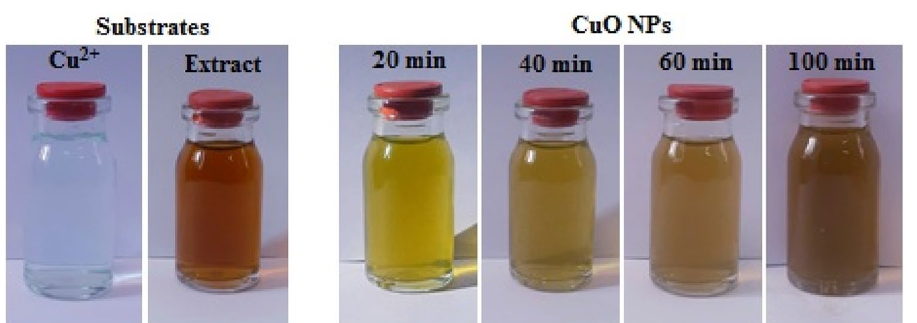
Figure 3. Visible detection of the biosynthesis of CuO